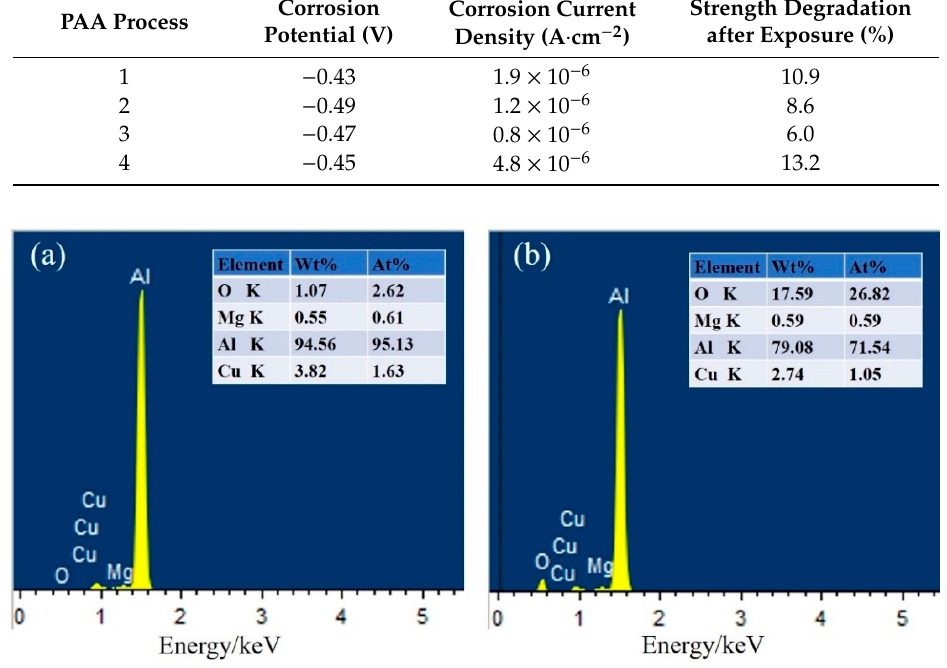
Figure 14. Oxygen contents of different substrates: ( a ) sandpaper abraded and ( b ) PAA-treated.